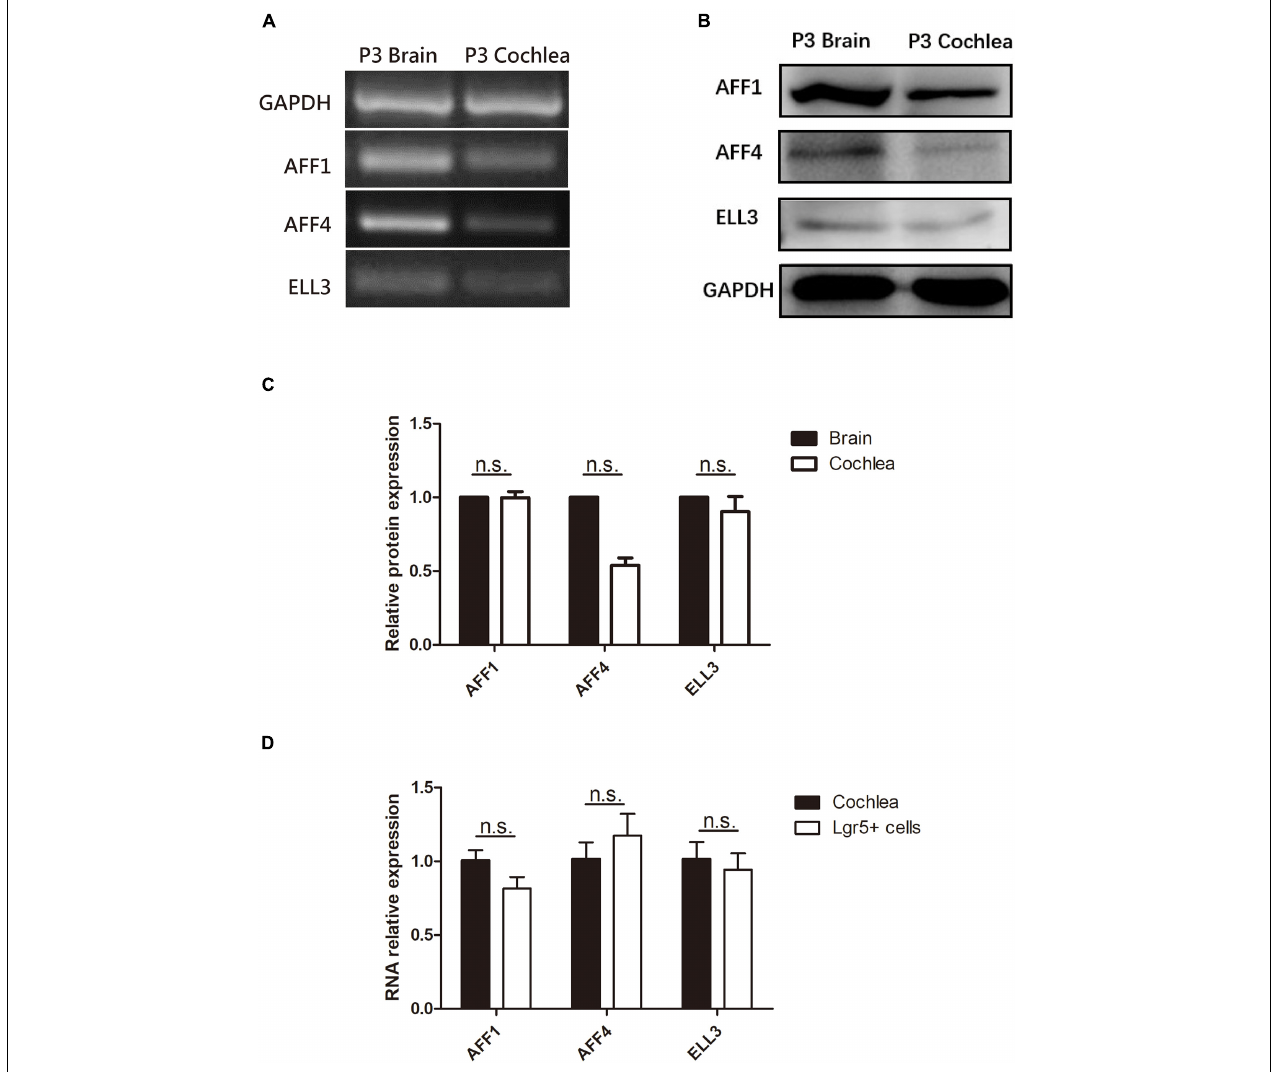
FIGURE 1 | The expression of AFF1, AFF4, and ELL3 in the neonatal mouse cochlea. (A,B) The mRNA and protein expression of AFF1, AFF4, and ELL3 in P3 mouse cochleae were detected by RT-PCR (A) and western blotting (B) , respectively. (C) The gray levels comparison of western blot. (D) The mRNA expression of AFF1, AFF4, and ELL3 in Lgr5+ cells. Brain samples of P3 mice were used as the positive control, and GAPDH was used as the internal reference. n.s., not significant.